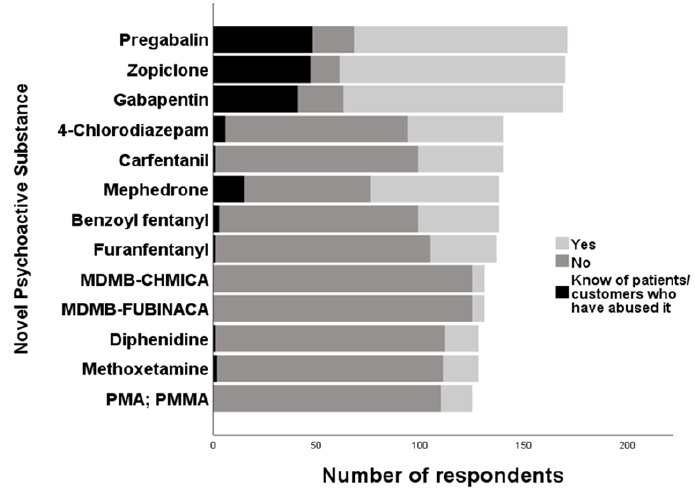
Figure 5. Most commonly known NPS by healthcare professionals (HCPs).